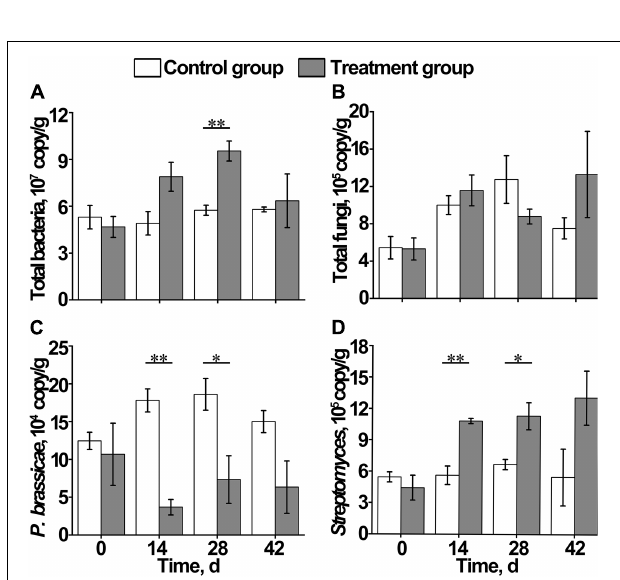
FIGURE 4 | Effect of S. alfalfae XY25 T on content of (A) total bacteria, (B) total fungi, (C) Plasmodiophora brassicae , and (D) Streptomyces . n = 3; the letter with * indicates significant differences at P < 0.05 level; the letters with ** indicate extremely significant differences at P < 0.01